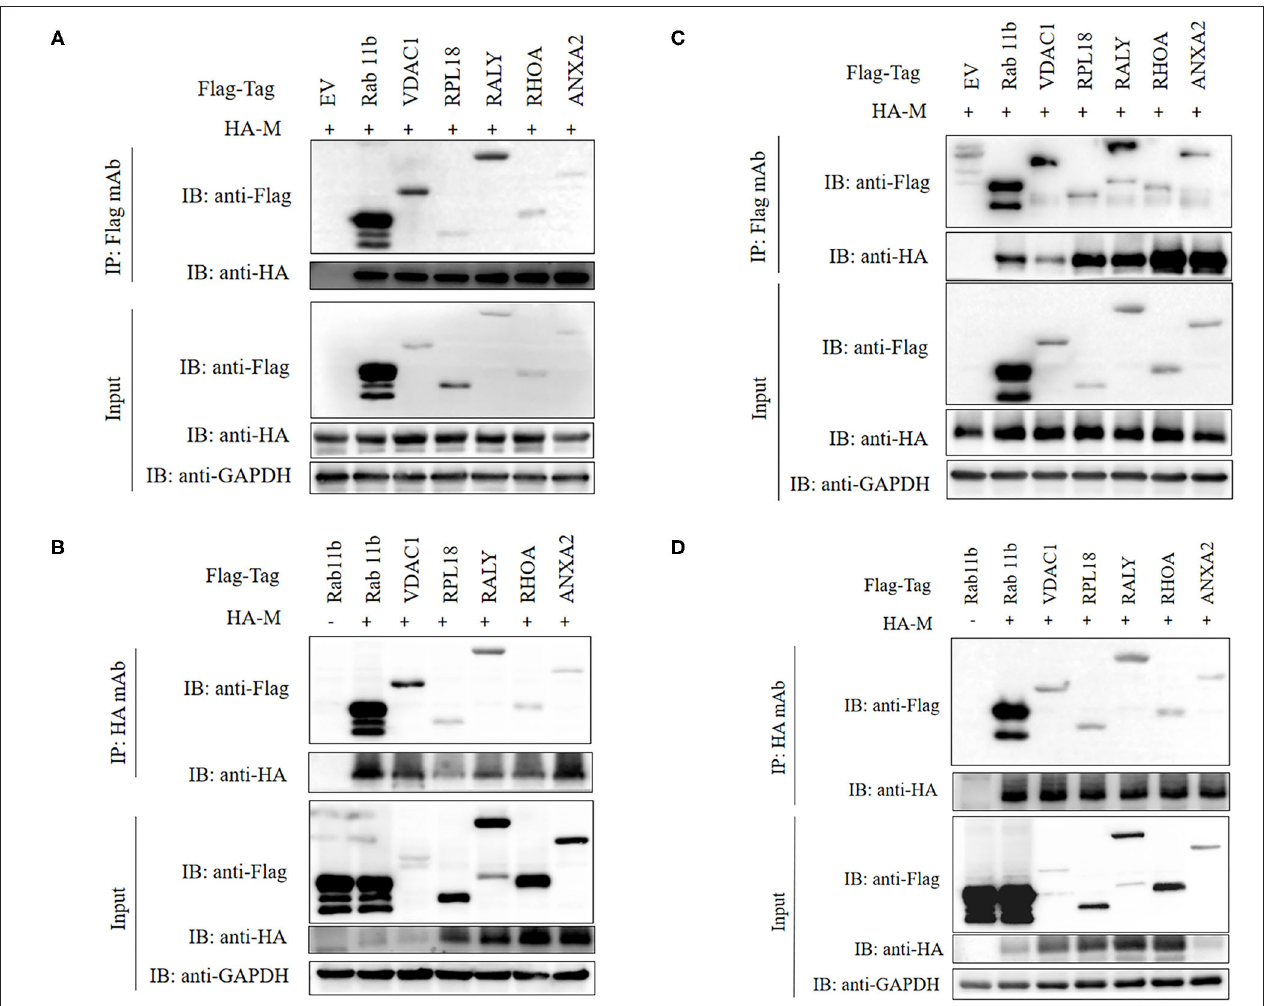
FIGURE 5 | Validation of M-host protein interactions. IPI-2I (A,B) and Vero (C,D) cells were co-transfected with plasmids expressing Flag-Rab11b, Flag-VDAC1, Flag-RPL18, Flag-RALY, Flag-RHOA, or Flag-ANXA2 and plasmids expressing HA-M, respectively. Among them, HA-M or Flag-Rab11b co-transfected with empty vector were served as negative controls, respectively. The cell lysates were immunoprecipitated with FLAG (A,C) or HA (B,D) beads, anti-Flag, or anti-HA mAbs, separated by sodium dodecyl sulfate-polyacrylamide gel electrophoresis (SDS-PAGE), Western-blotted and detected with corresponding antibodies, respectively. GAPDH was served as an internal loading